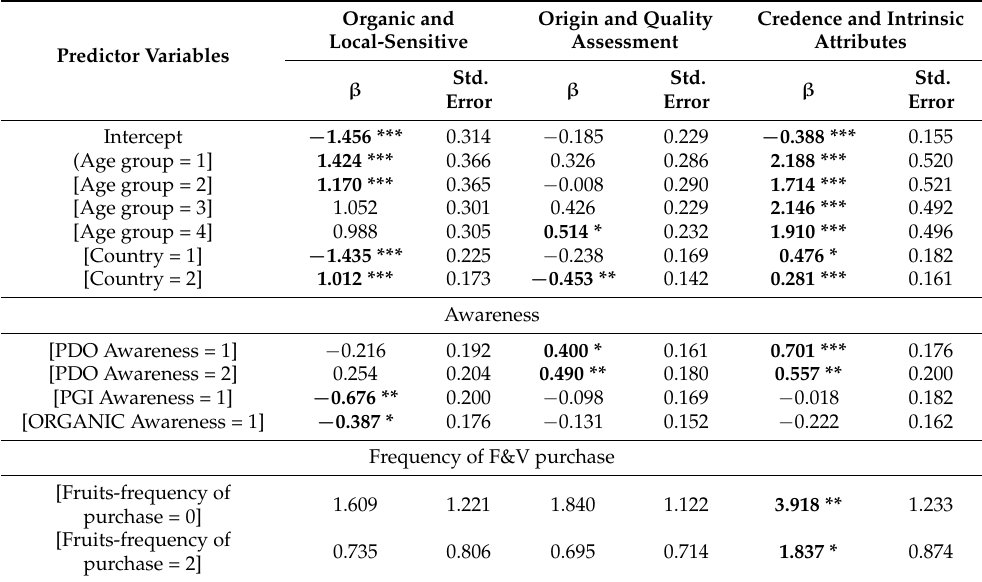
Table 6. The results of multinomial logistic regression analysis considering the significant socio- demographic awareness and habitudinal variables as a predictor of cluster membership are reported. Predictor Variables